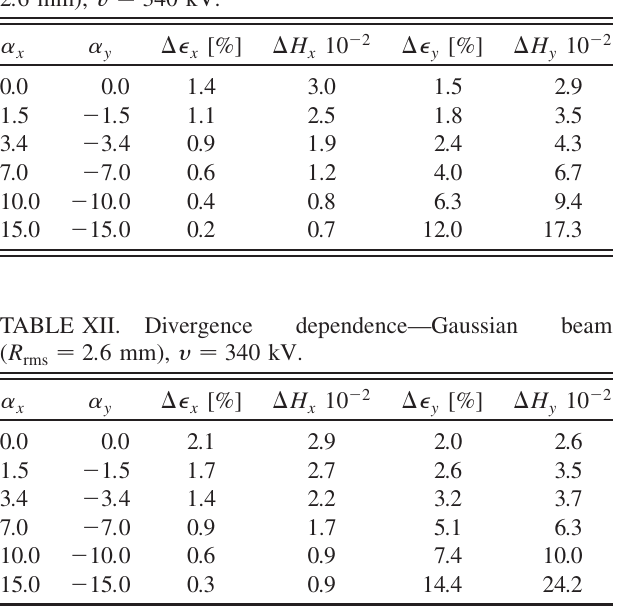
TABLE XI. Divergence dependence—uniform beam ( R rms ¼ 2